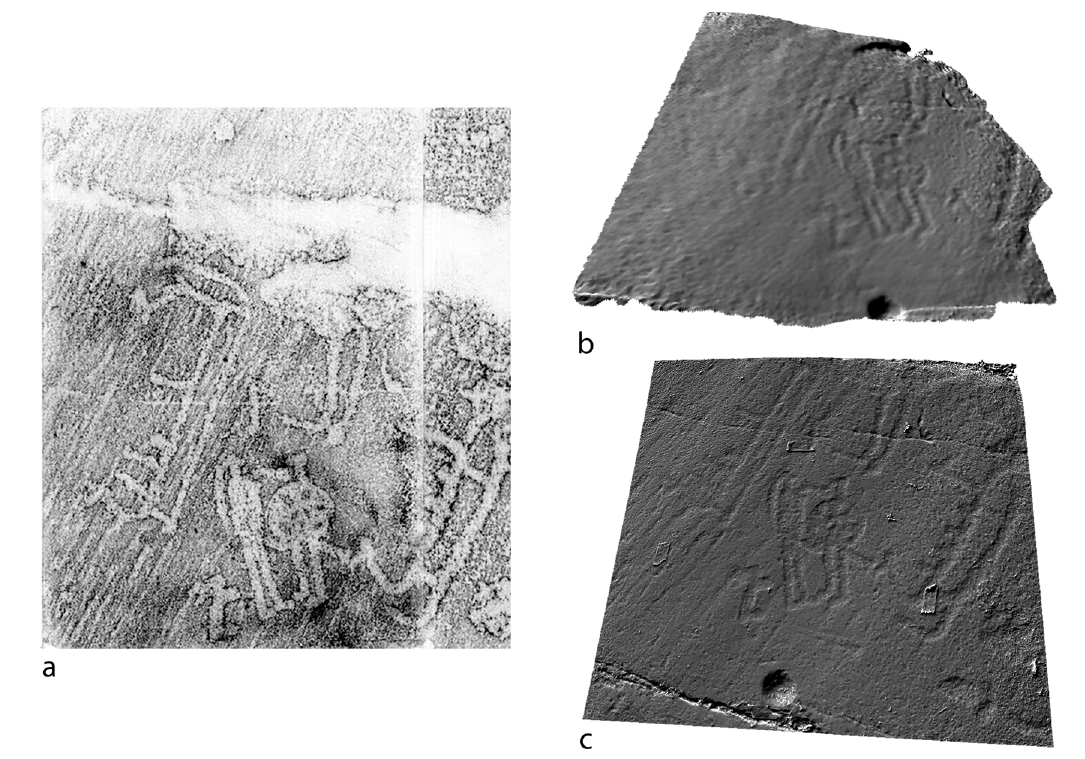
Figure 2. a. Frottage by RockCare of the intercourse scene in Finntorp, RAÄ Tanum 89:1; b. Sense laser scan of the couple by CH; c. SfM of the couple by